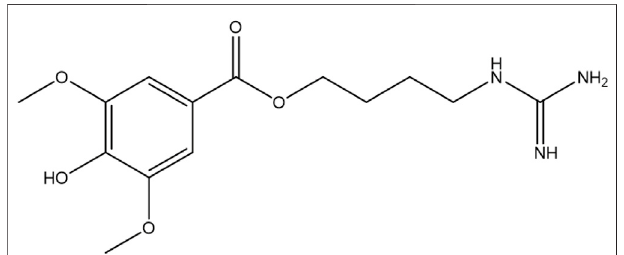
FIGURE 1 | Chemical structure of